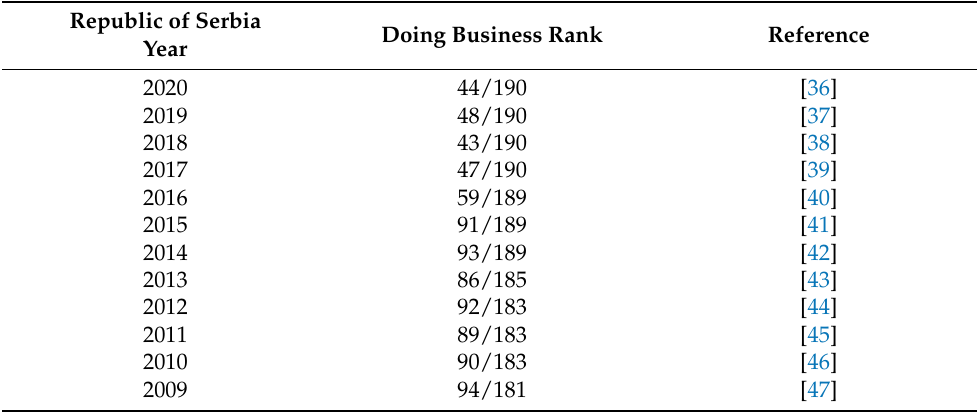
Table 1. Doing business ranks between 2009 and